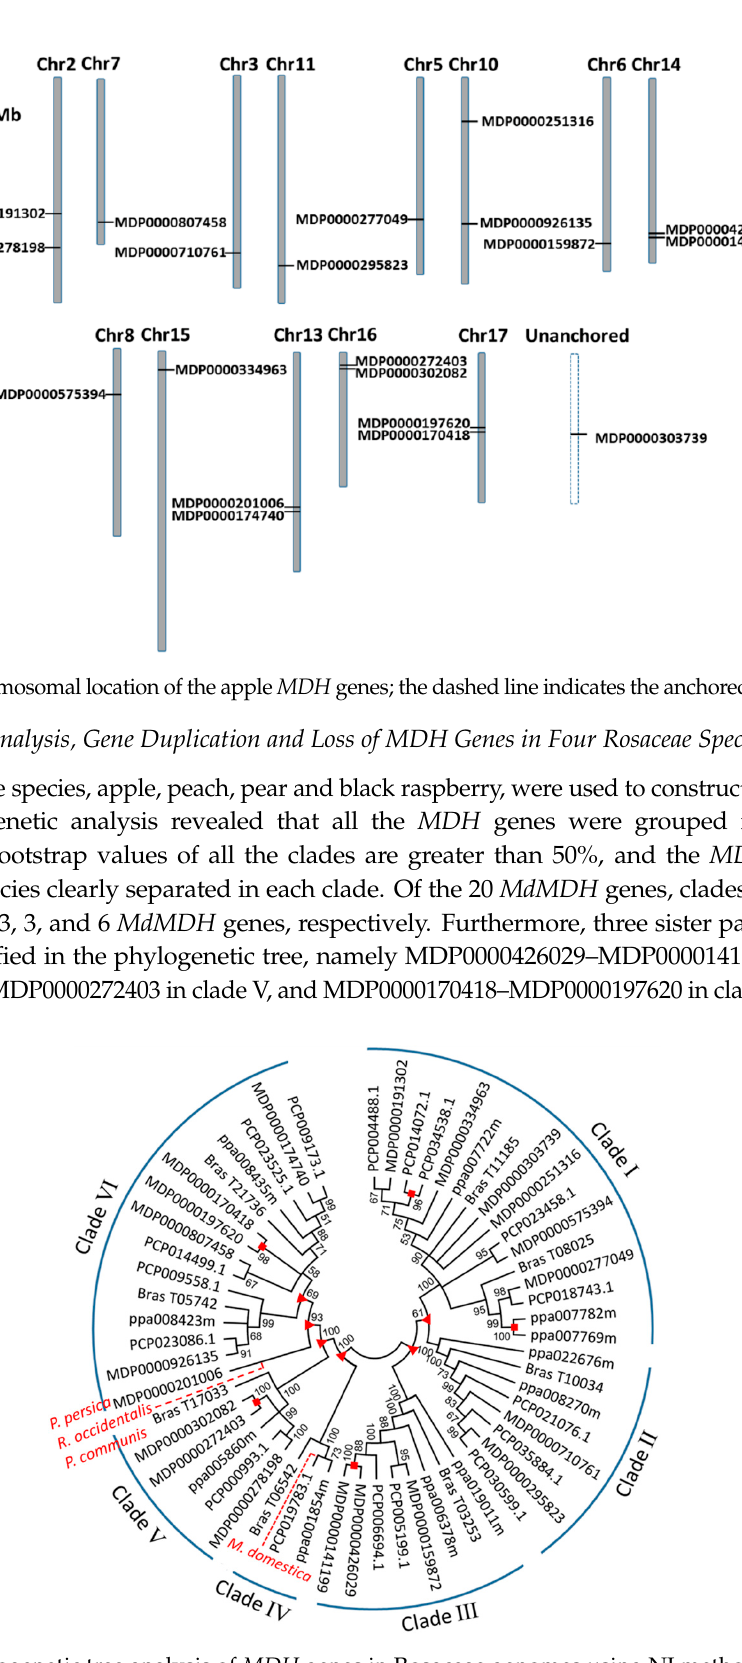
Figure 3. Phylogenetic tree analysis of MDH genes in Rosaceae genomes using NJ method. Old and recent duplication events are represented by red triangle and square, respectively. Gene loss is indicated by red dash line. Bootstrap values (higher than 50%) are shown near branched lines.